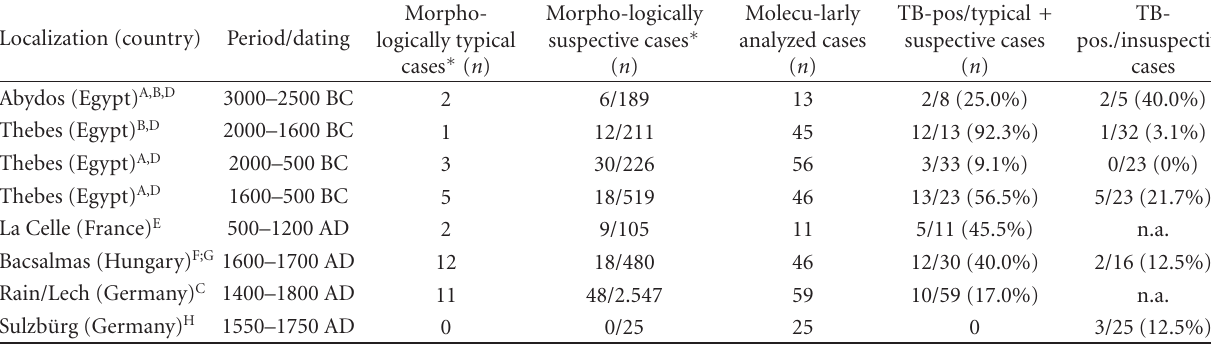
Table 1: Molecular paleoepidemiology of tuberculosis in various historic